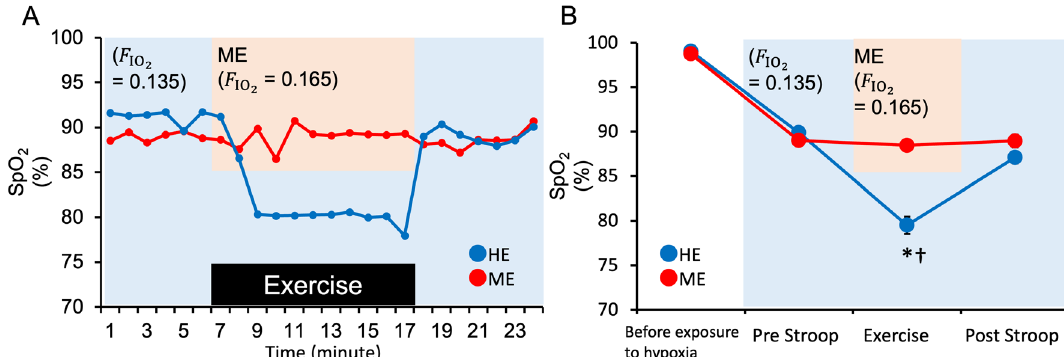
Figure 1. ( A ) A typical example of the percutaneous arterial oxygen saturation (SpO 2 ) during exercise. Immediately before exercise, the inhaled hypoxic gas was switched from hypoxia ( F IO 2 = 0.135; blue background) to a milder hypoxic gas ( F IO 2 = 0.161 ± 0.018; orange background), which was adjusted so that SpO 2 during exercise remained at the resting level in the ME condition (red). Immediately after the end of the exercise, the inhaled hypoxic gas was again returned to hypoxia ( F IO 2 = 0.135). ( B ) The mean and standard deviation of SpO 2 under hypoxic exercise (HE) (blue) and milder hypoxic exercise (ME) (red) conditions. Values are presented as mean ± standard error. * P < 0.05 versus (vs.) ME condition, † P < 0.05 vs. pre-Stroop.